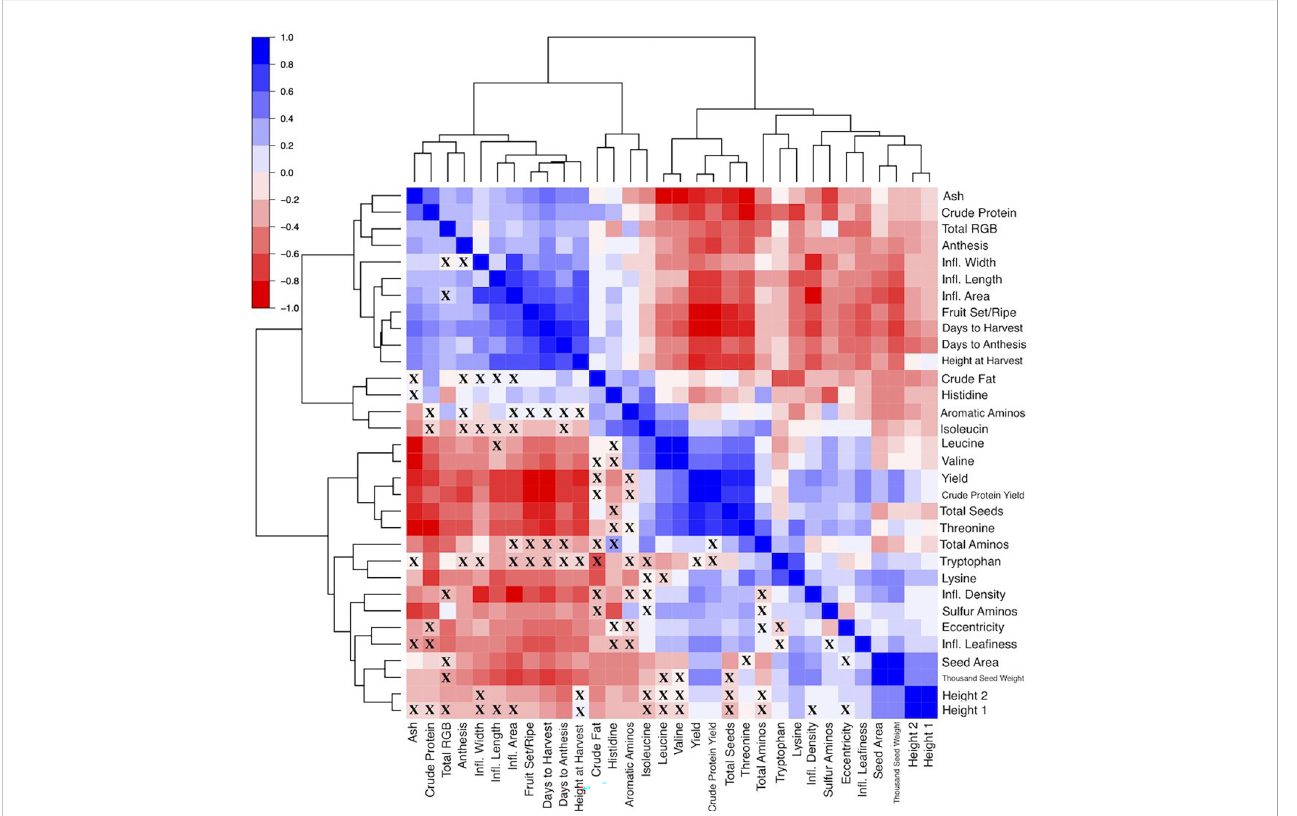
FIGURE 5 Heat map visualization of the correlation matrix, where Spearman correlation coef fi cients range from -1 (solid red fi ll) to 1 (solid blue fi ll). The dendrogram is constructed using hierarchical clustering of the variables included on the edges. Correlations that are not signi fi cant (p > 0.05) are denoted by an “ X ” in the corresponding cell. Note: DTA, Days to Anthesis; Anth, Anthesis (days); FSR, FruitSet/Ripening (days); DTH, Days to Harvest; Ht_1, Plant Height-5wk After Sowing (cm); Ht_2, Plant Height-6wk After Sowing (cm); Ht_Harv, Plant Height-Harvest (cm); In fl _L, In fl orescence Length (cm); In fl _W, In fl orescence Width (cm); In fl _Area, In fl orescence Area (cm); In fl _Density, In fl orscence Density; In fl _Lea fi ness, In fl orescence Lea fi ness; Ash, Ash Content;CF, Crude Fat Content;CP, Crude Protein Content;TAA, Total Amino Acid Content;His, Histidine Content; Ile, Isoleucine Content; Leu, Leucine Content; Lys, Lysine Content; SAA, SAA Content; AAA, AAA Content; Thr, Threonine Content; Trp, Tryptophan Content; Val, Valine Content; CP Yield, Crude Protein Yield (g plant-1); Yield, Yield (g plant-1); TSW, Thousand Seed Weight (g); Seeds, Total Seeds per plant; Area, Seed Area (mm2); Eccen, Seed Eccentricity; sumRGB, Total Red, Green,